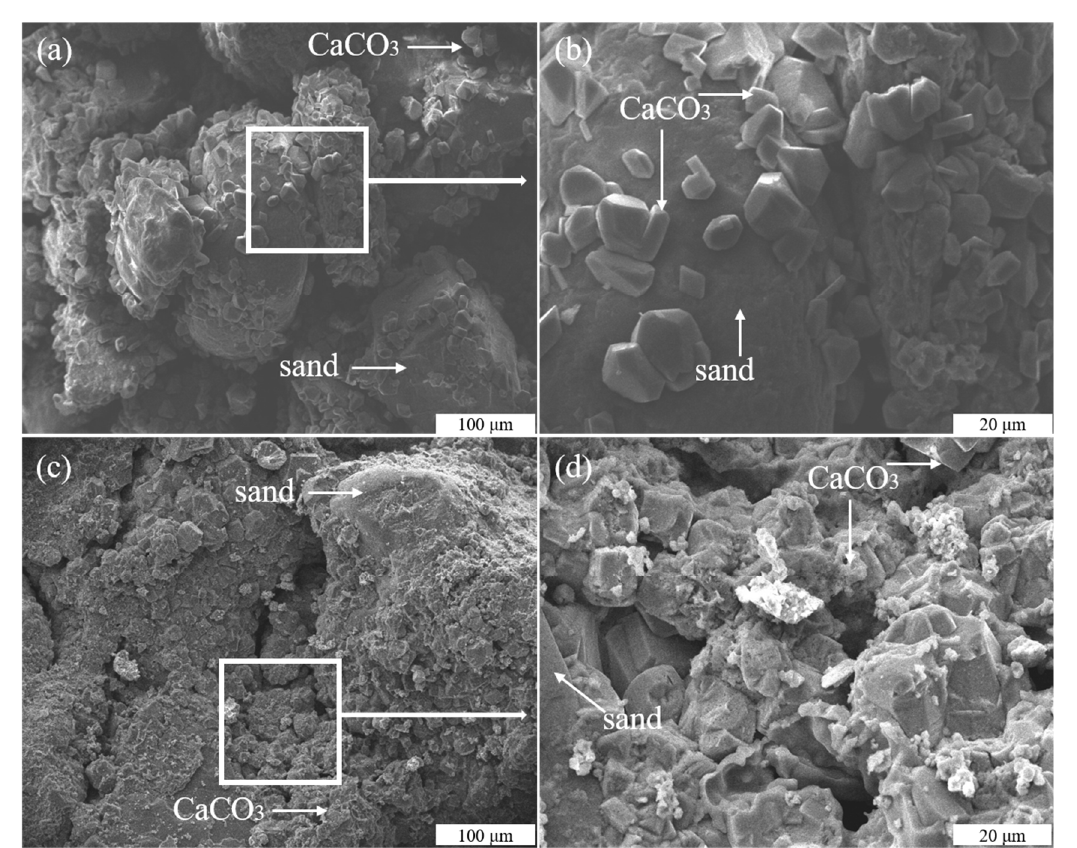
Figure 10. SEM images of the consolidated sandy soil samples without ( a , b ) and with NA-MMT ( c , d ).